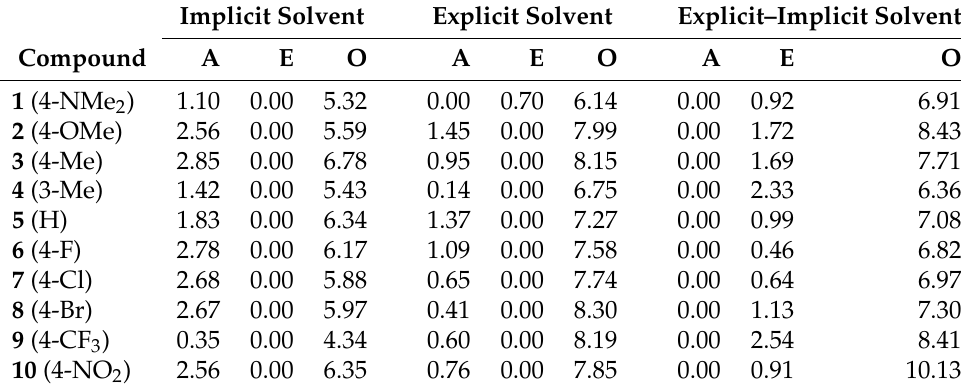
Table 3. Relative Gibbs free energy (kcal/mol) with respect to the lowest energy amide ( A ) tautomer for the implicit solvent model PCM, explicit solvent model, and the hybrid implicit–explicit solvent model with single explicit DMSO molecule. Implicit Solvent Explicit